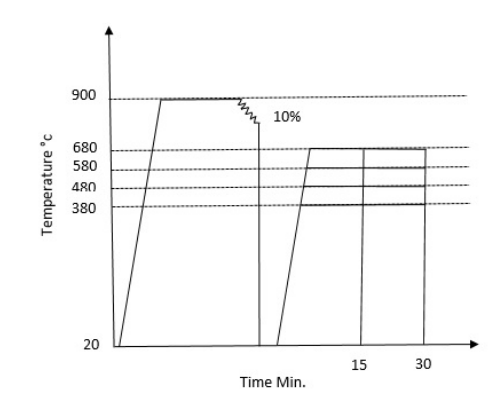
Figure 1. Thermal and Thermomechanical Sequences.